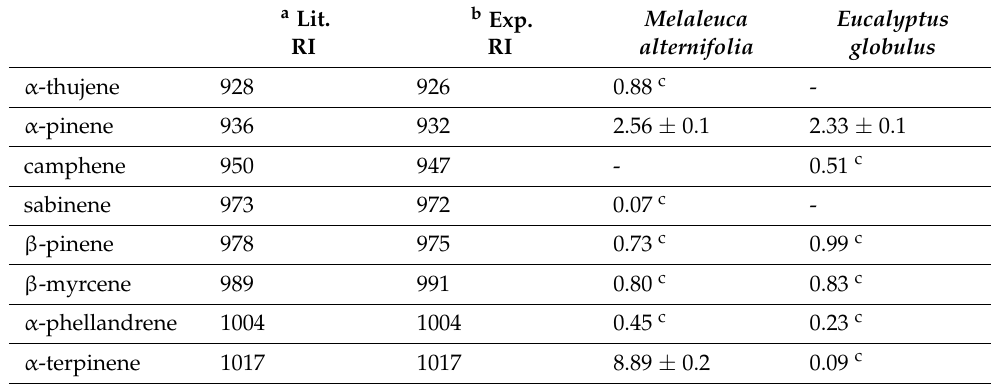
Table 1. Qualitative and semi-quantitative analysis of Malaleuca alternifolia Chell (TTO) and Euca- lyptus globulus Labill. (EEO) EOs. Data are expressed as % relative peak area values ± standard deviation